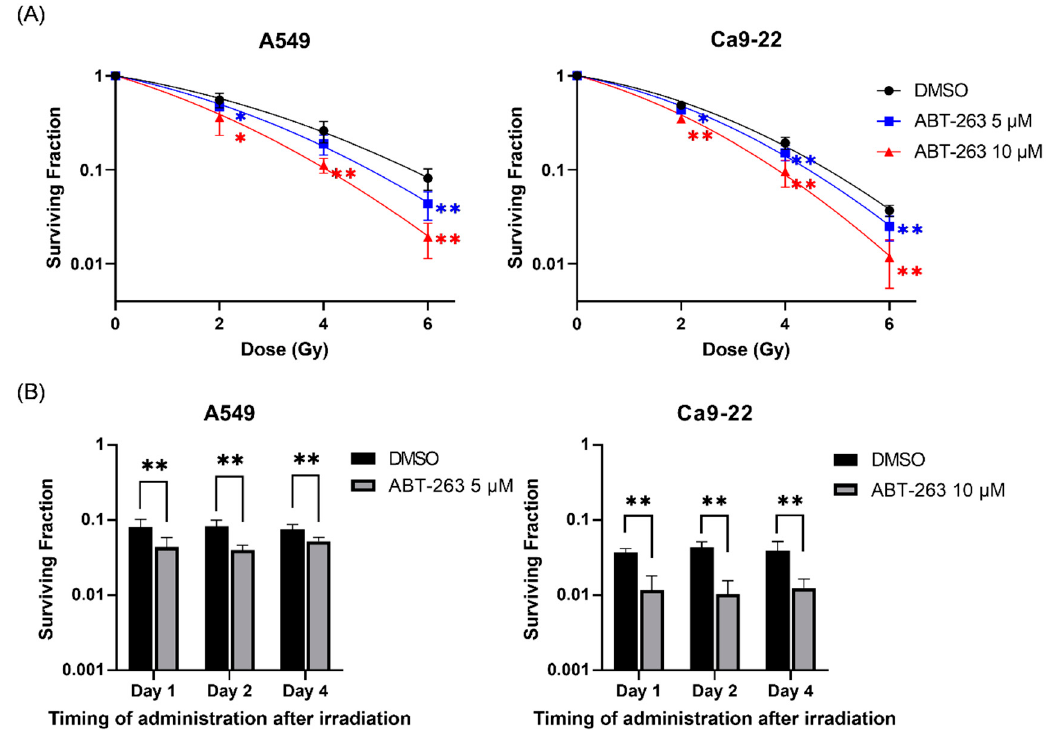
Figure 2. Effects of ABT-263 on the survival of irradiated cancer cells. ( A ) X-irradiated A549 and Ca9-22 cells were cultured for 24 h prior to the addition of ABT-263 to the culture. After further culture, the colony number was counted and the surviving fraction was calculated. ( B ) A549 and Ca9-22 cells were irradiated at 6 Gy. At 1, 2, and 4 days after irradiation, ABT-263 was added to the culture. After culture, the surviving fraction was calculated. Data are presented as the mean ± SD of independent experiments. * p < 0.05, ** p < 0.01.